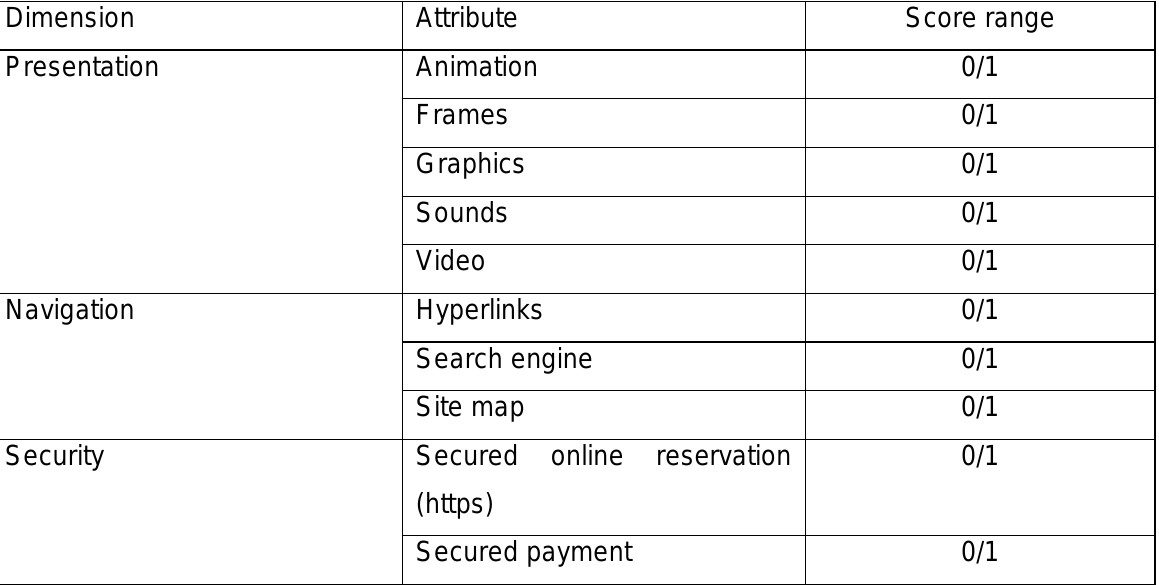
Table 1. Hotel Website Information Design